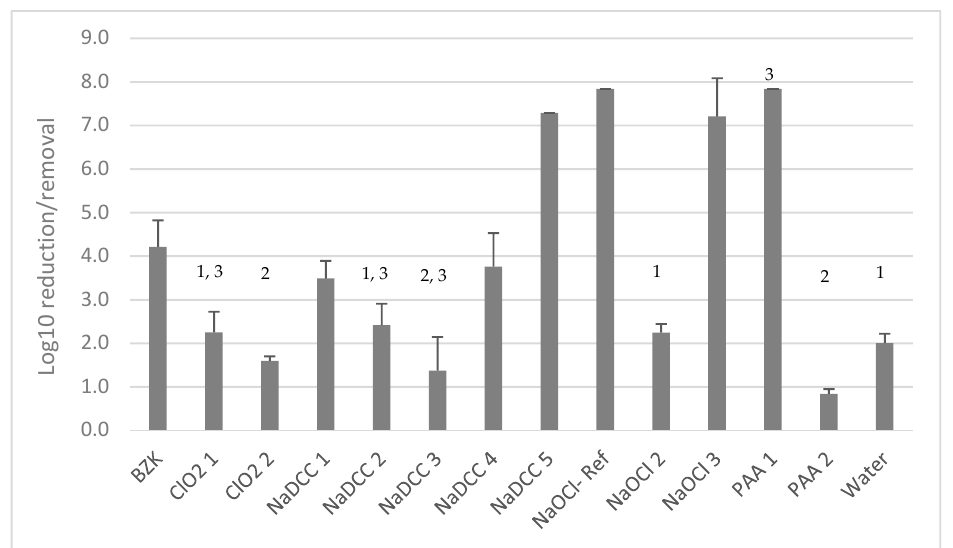
Figure 2. Product efficacy in killing/removing C. auris embedded in a DSB. 1: indicates no statistical difference (one-way ANOVA, p > 0.05) in log 10 reduction/removal from surfaces; 2: log 10 reduction/removal lower than wiping with water (one-way ANOVA, p < 0.05); and 3: indicates that only two biological replicates were performed.